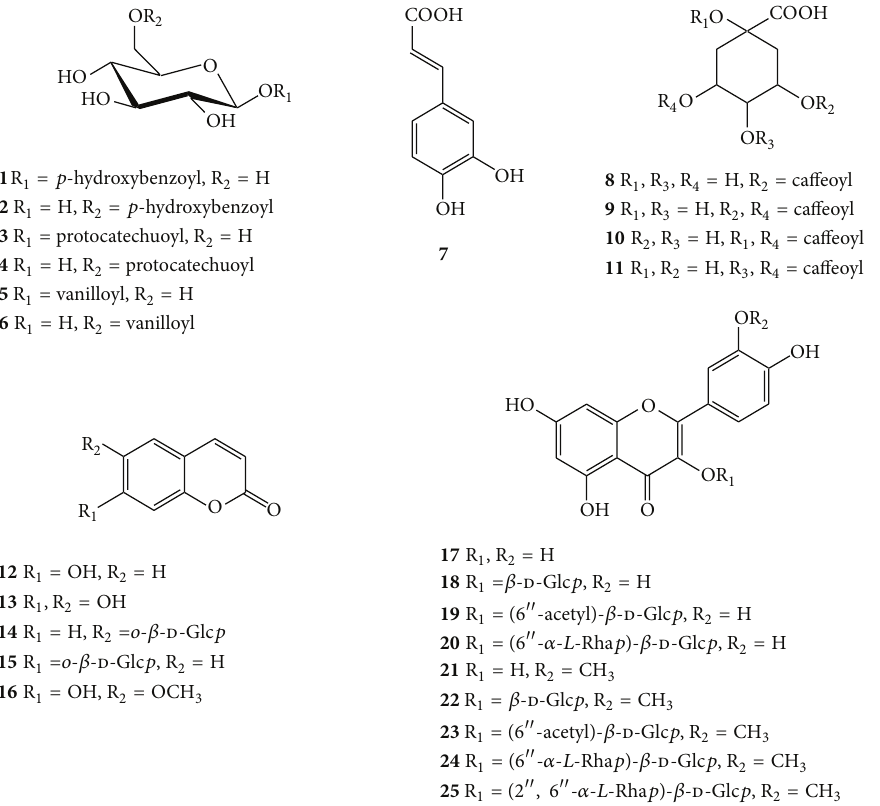
Figure 2: Chemical structures of compounds 1 – 25 isolated from C. officinalis leaves. Glc p —glucopyranose, Rha p —rhamnopyranose.